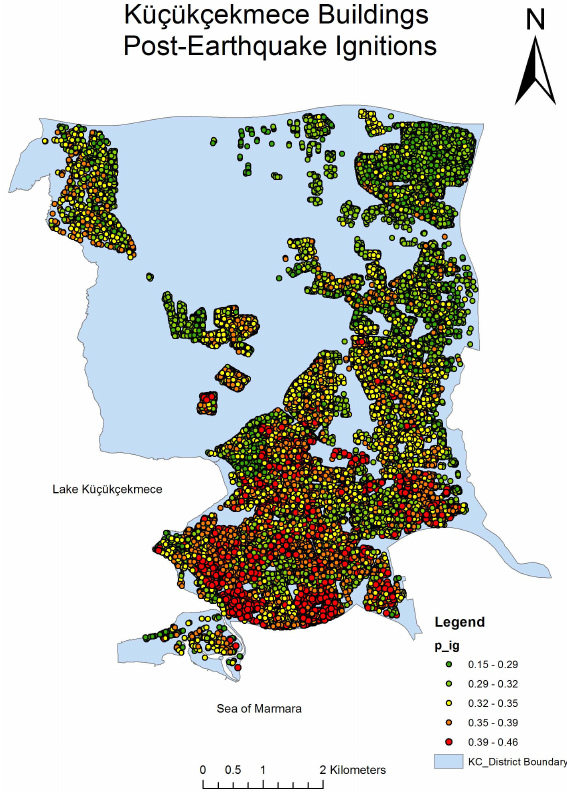
Fig. 9. Visualized results of post-earthquake ignition